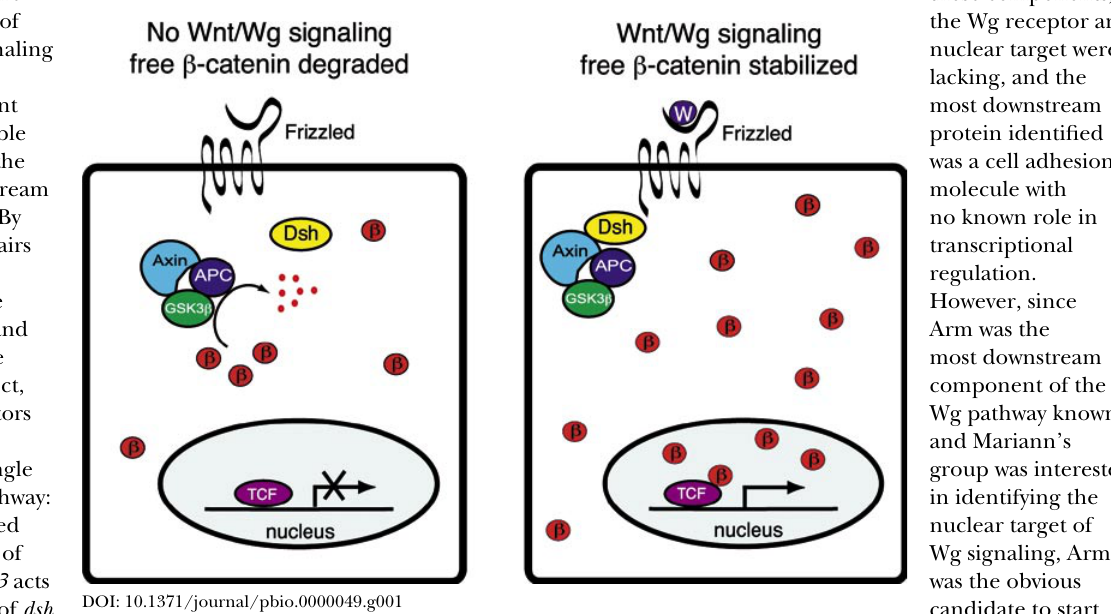
Figure 1. A Simplified Version of Wnt/Wg Signaling In the absence of the Wnt ligand, Arm/  -catenin (  ) is phosphorylated by a complex of Axin, APC, and Zw3/GSK3  and rapidly degraded. Upon Wnt (W) signaling through the Frizzled receptor and Dsh, this complex is inhibited: as a consequence,  -catenin accumulates and binds to LEF/TCF proteins to stimulate transcription of Wnt target